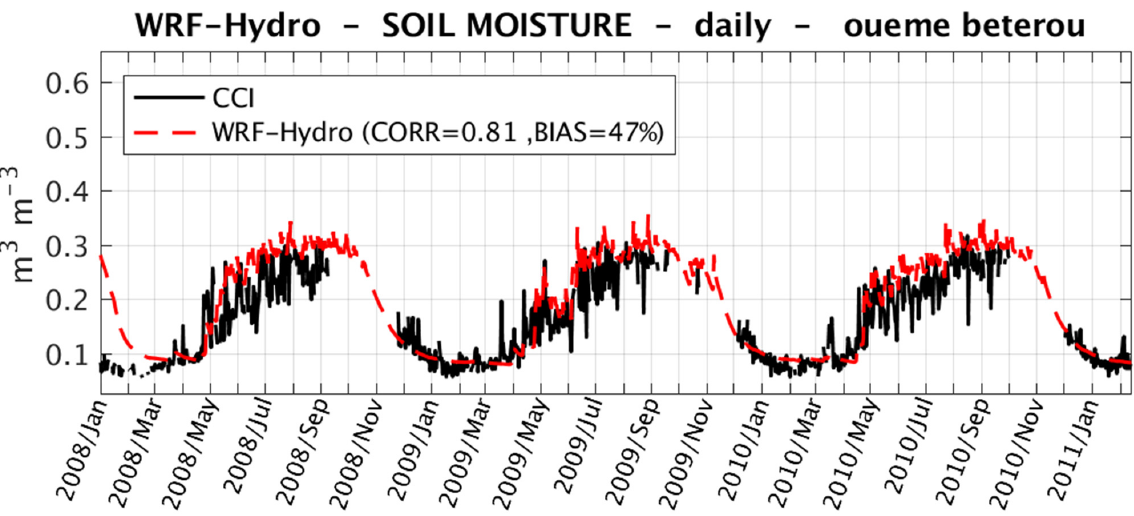
Figure 12. Evaluation of the soil moisture between the simulated with WRF-H of the first Noah LSM soil layer (from 0 to 10 cm) and the daily average from CCI (from 0.5 to 2 cm) over the Bétérou catchment.